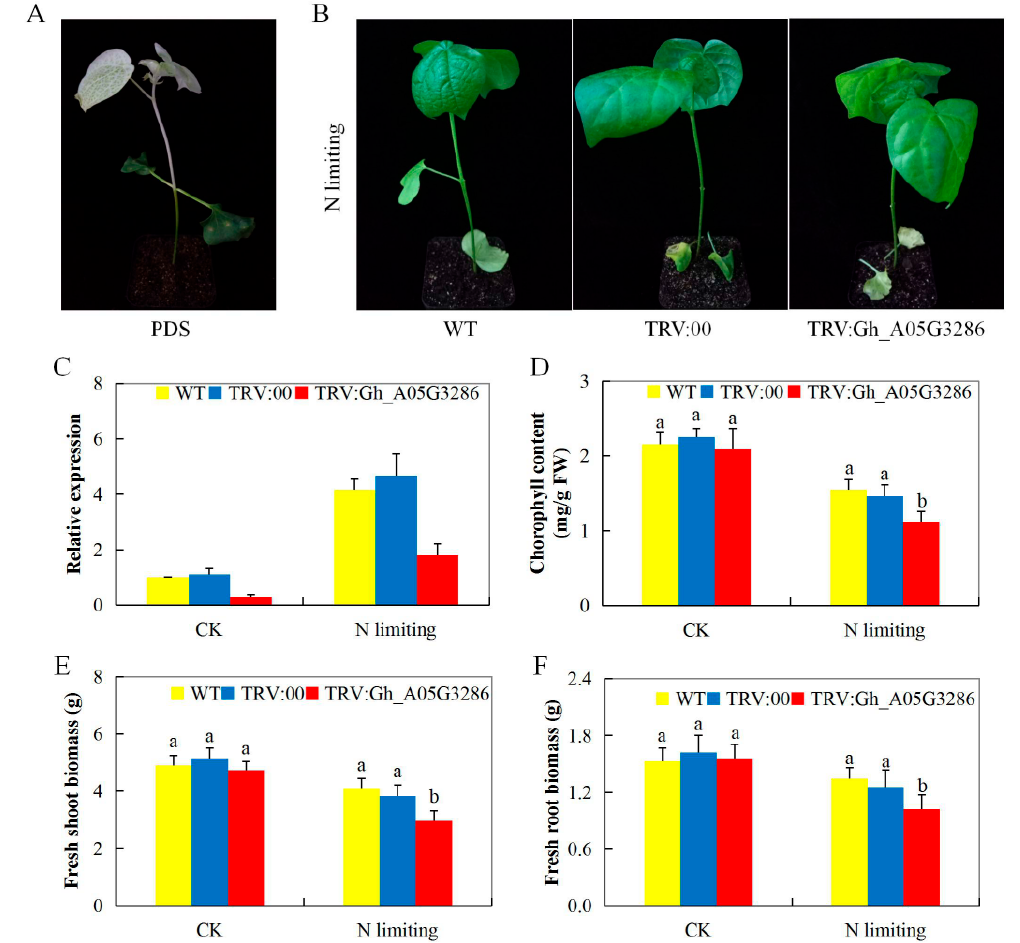
Figure 5. Phenotype observed in the silenced plants with the TRV: 00 empty vector, wild type plants and Gh_A05G3286 (NLP5) -silenced plants at 12 days post-inoculation. ( A ) Albino appearance on the leaves of the PDS infused plants. ( B ) Photograph of the plants taken after 15 days of N-deficiency exposure. ( C ) RT-qPCR analysis of the change in the expression level of the Gh_A05G3286 (NLP5) gene in cotton plants treated with VIGS. ( D – F ) Evaluation of chlorophyll, fresh shoot biomass and fresh root biomass, “TRV:00” represents the plants carrying control the TRV2 empty vector, “TRV: Gh_A05G3286 (NLP5) ” represents the Gh_A05G3286 (NLP5)- silenced plants. Letters a/b indicate statistically significant differences (two-tailed, p < 0.05). The error bars of the Gh_A05G3286 (NLP5) gene expression level represent the standard deviation of three biological replicates.